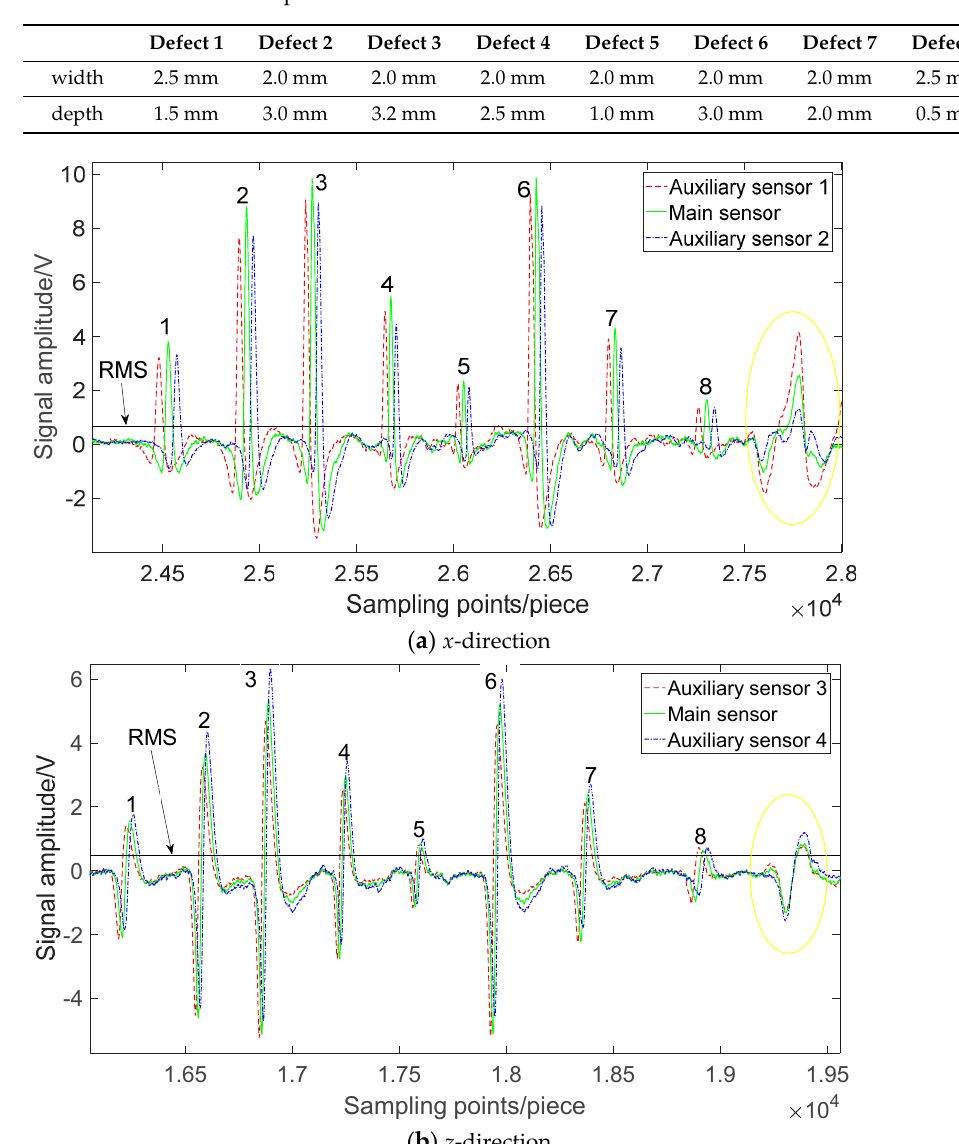
Figure 15. A rail with multiple artificial defects. Table 2. The width and depth of each defect.